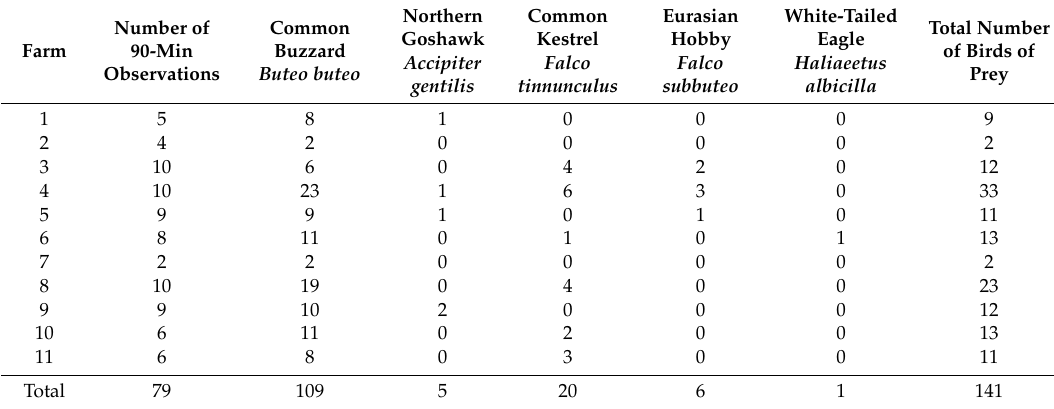
Table 3. Sightings of birds of prey during field